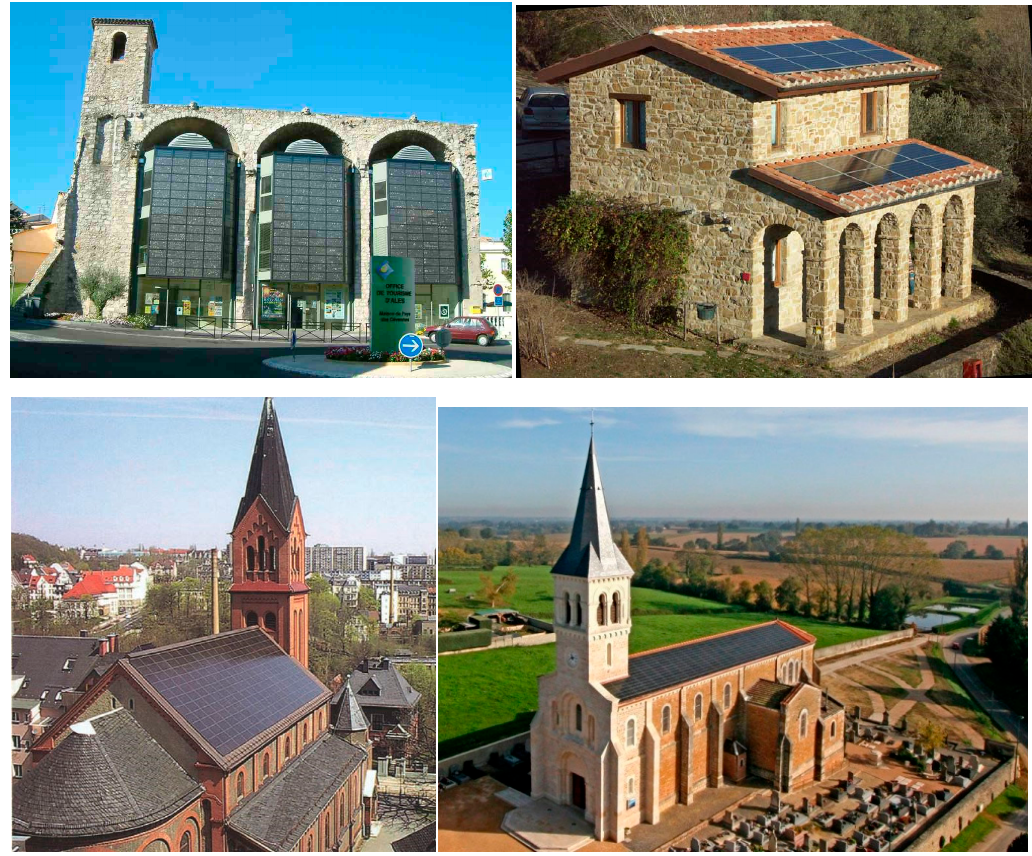
Figure 3. Implementation of somewhat controversial photovoltaic systems on heritage buildings .